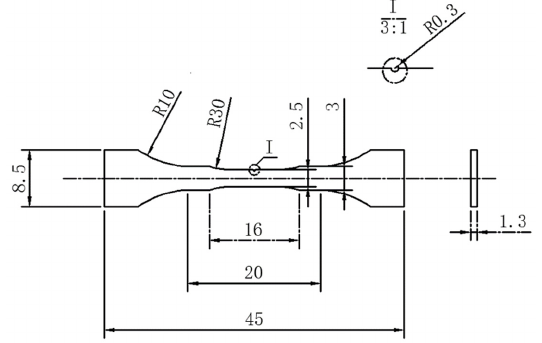
Figure 1. Dimensions of in-situ tensile samples